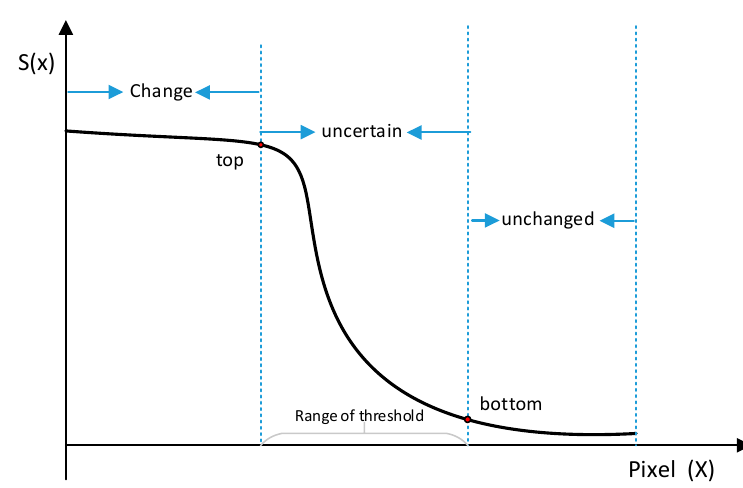
Figure 4. Schematic of the TRP technique for predicting the threshold range (S(x) is the slope value, and x is the pixel value of the filtered change magnitude image (FCMI).